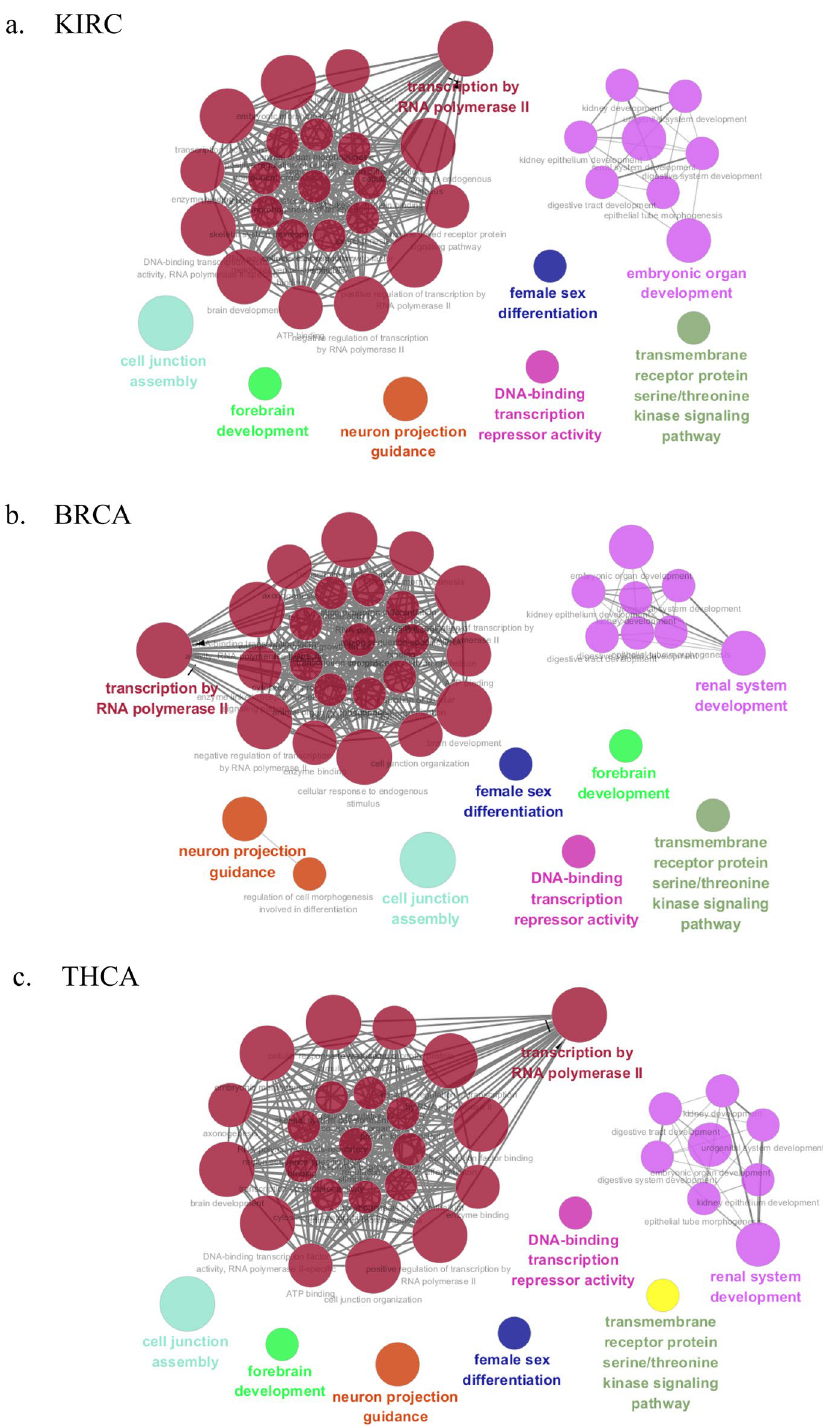
Figure 2. Cluego analysis for GO terminology on nine datasets. Node: GO term; the bigger the node, the smaller the P value; Each line indicates the correlation between functions, and a larger kappa coefficient represents the line is more thicker; different colors denote the function enrichment classification of GO terms. Networks were generated with ClueGO (version 2.5.7) in Cytoscape (version 3.6.0) (http:// apps. cytos cape. org/ apps/ cluego). ( a ) KIRC, ( b ) BRCA, ( c ) THCA, ( d ) HNSC, ( e ) KIRP, ( f ) LUSC, ( g ) LIHC, ( h ) COAD, ( i )